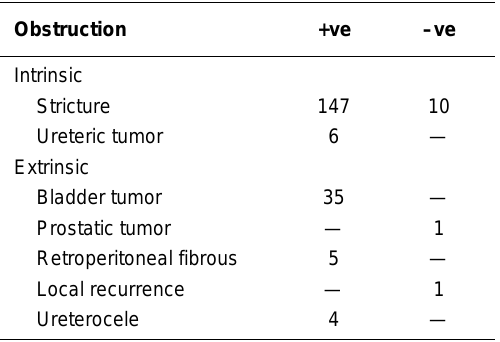
True Positive and Negative Values at sMRU